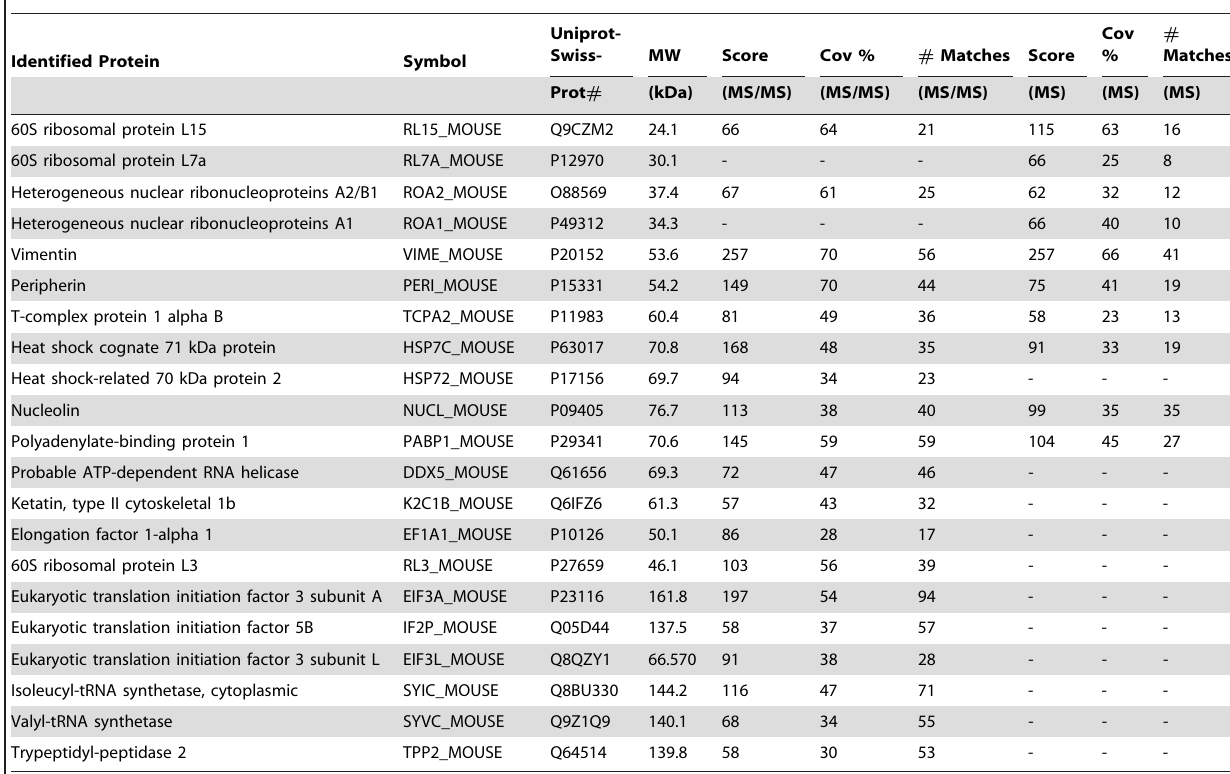
Table 1. Identification of membrane proteins able to bind A b 1–42 large oligomers.